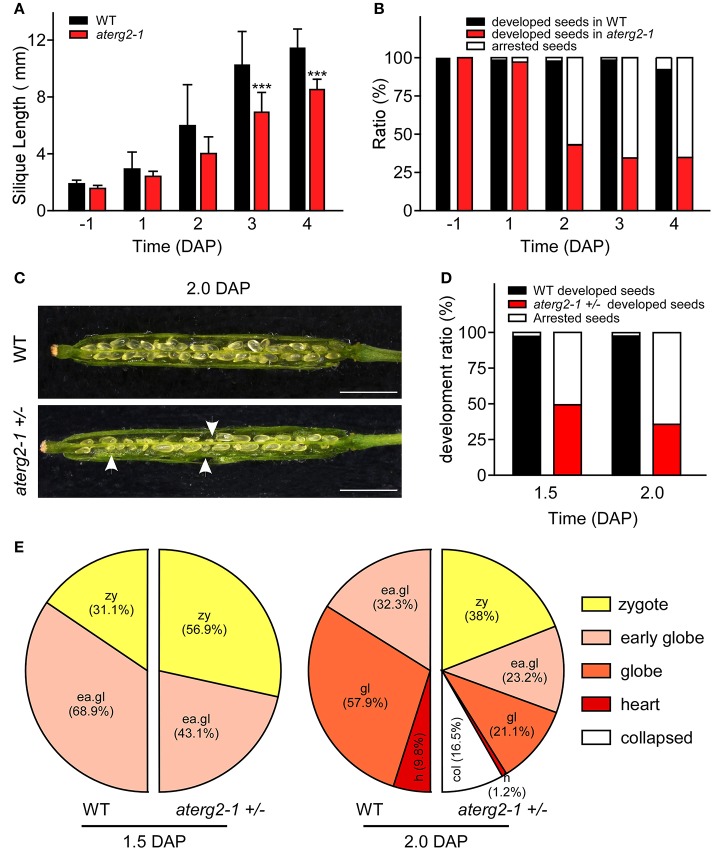
The development phenotypes of early seeds and ovules in WT and aterg2-1 +/−. (A) The silique length of WT and aterg2-1 +/− measured from the day before pollination to four DAP (n = 16). The values are means ± SD. *** indicates extremely statistically significant values (P < 0.001). (B) The seed abortion ratio of WT and aterg2-1 +/− calculated from the day before pollination to 4 DAP (silique number = 8). (C) The opened 2.0-DAP siliques from WT (top) and aterg2-1 +/− (bottom). The arrows point to the aborted seeds. Bar = 1 mm. (D) The seed abortion ratio of WT and aterg2-1 +/− at 1.5- and 2.0-DAP, respectively. Silique numbers = 8. (E) The ratio of developed ovules in WT and aterg2-1 +/− at 1.5- and 2.0-DAP, respectively. The seed numbers of WT and aterg2-1 +/− at 1.5-DAP are 190 and 167, respectively; that of WT and aterg2-1 +/− at 2.0-DAP are 183 and 237, respectively.